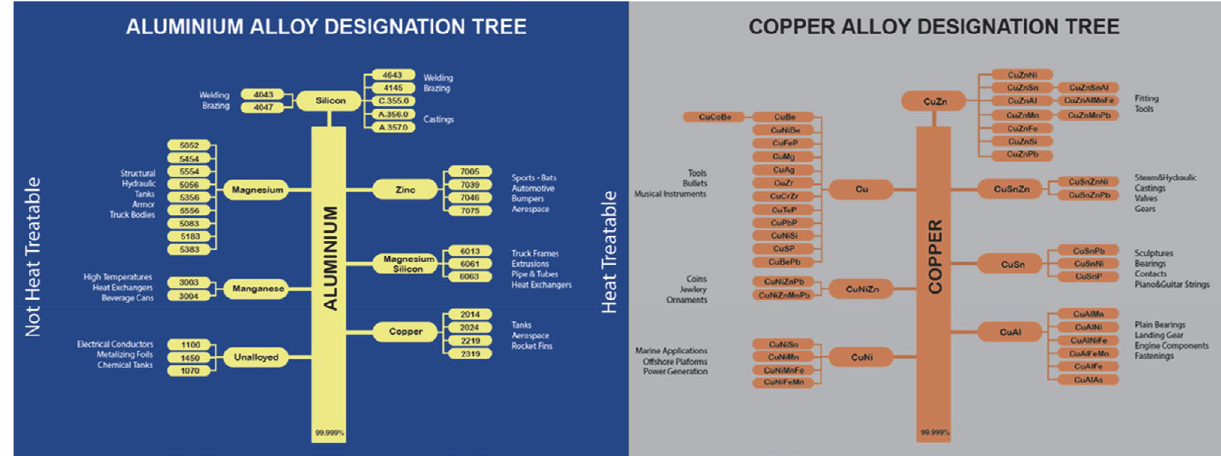
Figure 3 . Families of aluminium and copper alloys (modified from ref. 15 and ref.